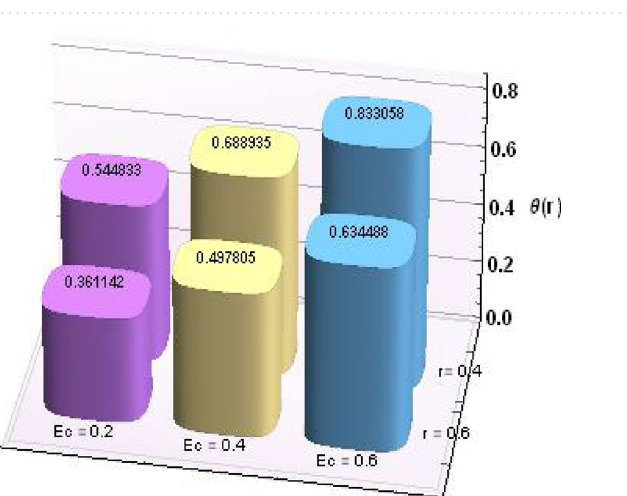
Figure 13. Variation in w(r) against M .